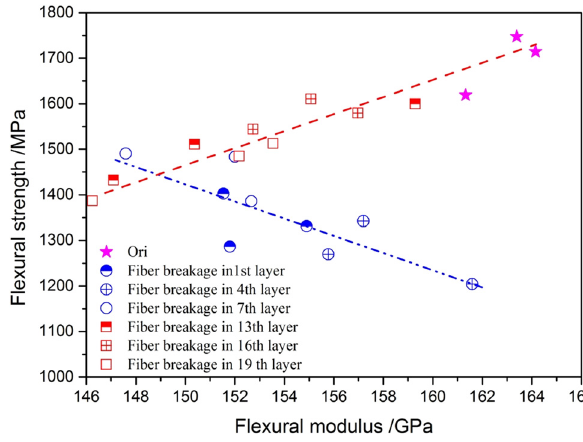
Figure 6: Relationship between flexural modulus and strength of CF/ epoxy laminates with fiber breakage in